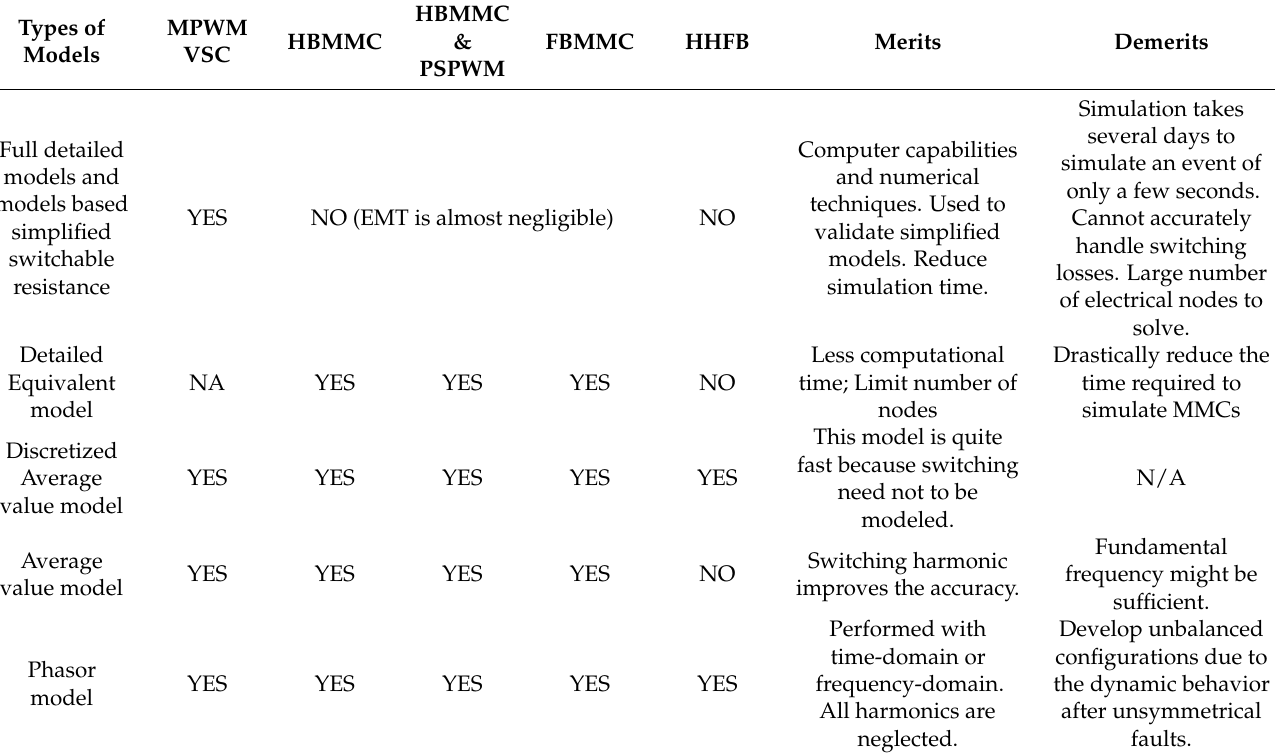
Table 1. Summary of different HVDC models configurations and merits and